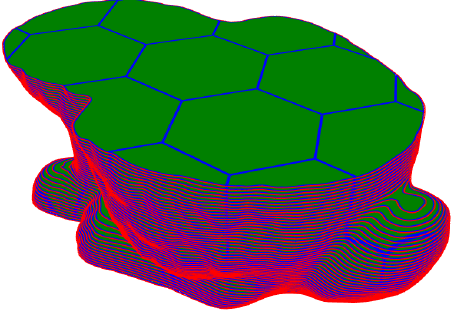
Figure 8. Hexagonal partition and scan filling of slice data.